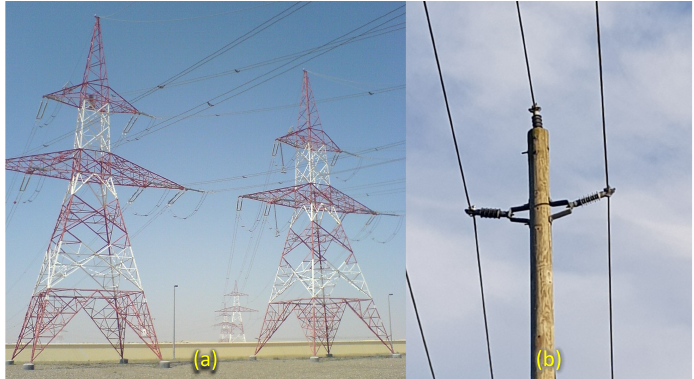
Figure 10. Photos of ( a ) a 220-kV overhead transmission line where outdoor insulators are employed to electrically isolate the conductors from the grounded towers, and ( b ) is a 12.47-kV wooden post using polymer insulators for isolating the conductors from the